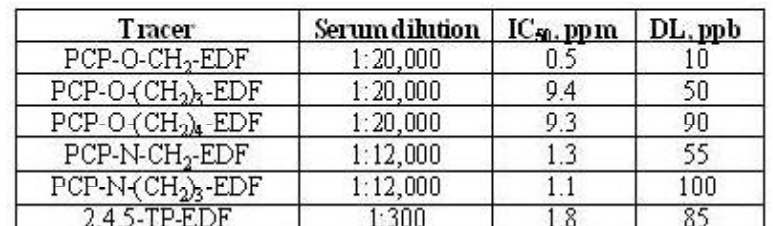
Titers of Antisera and PFIA Characteristics: IC Values and Limits of Detection (DL) for 50 Different Tracers and Serum Anti-PCP-BSA